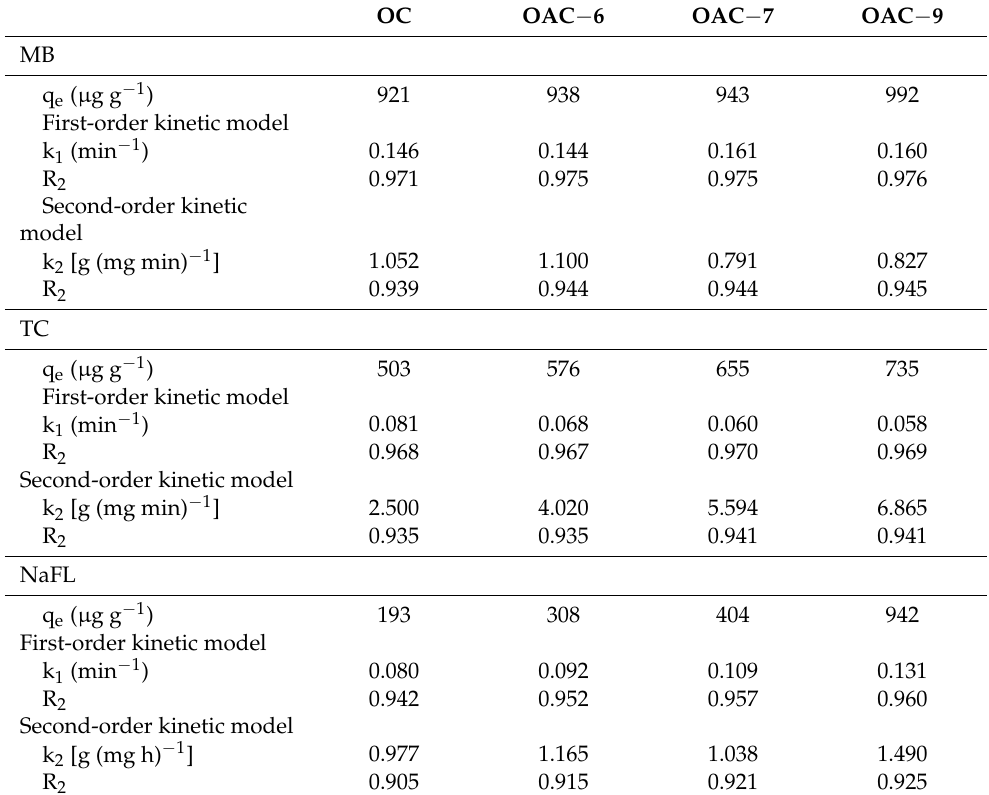
Table 3. Kinetic parameters of the pseudo-first-order models and pseudo-second-order models for MB, TC, and NaFL adsorption to the carbonaceous